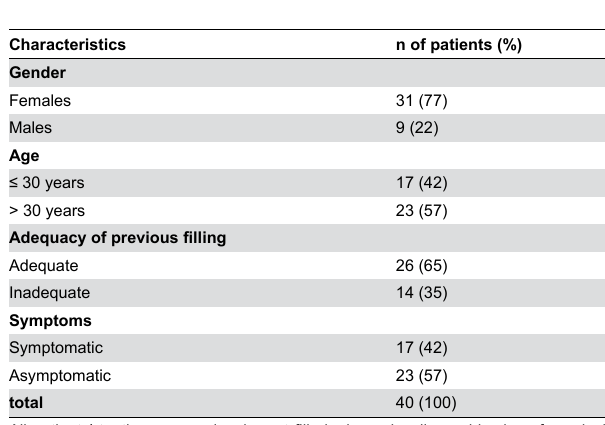
Table 1. Distribution of patients’ characteristics.